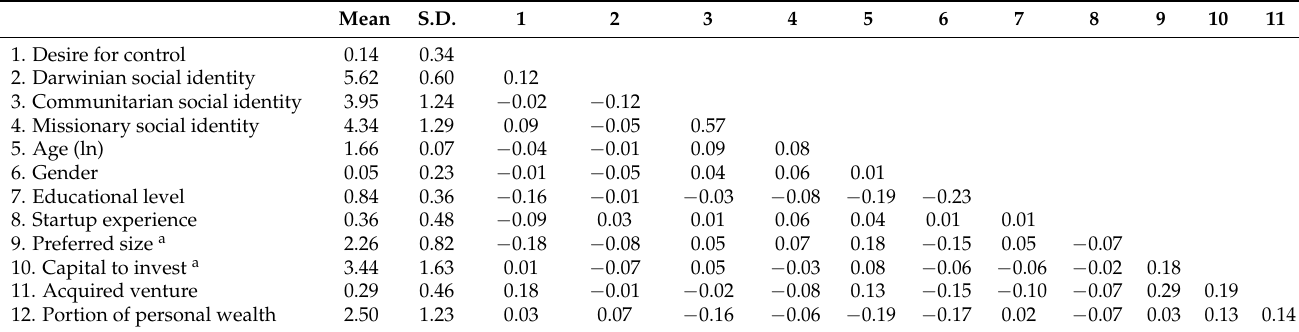
Table 1. Descriptive statistics and